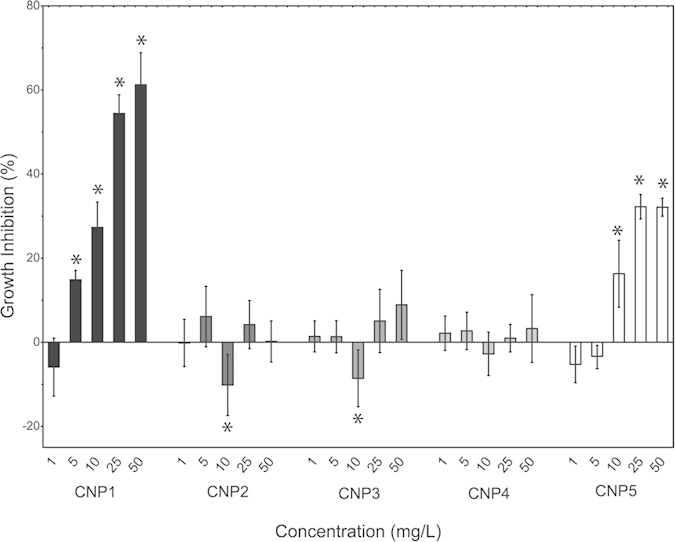
Effect of 72 h exposure to the five CNPs on growth of P. subcapitata.Data are expressed as percentages of the value of untreated cells (mean ± standard deviation). Statistically significant differences (p < 0.05) are marked by asterisks.